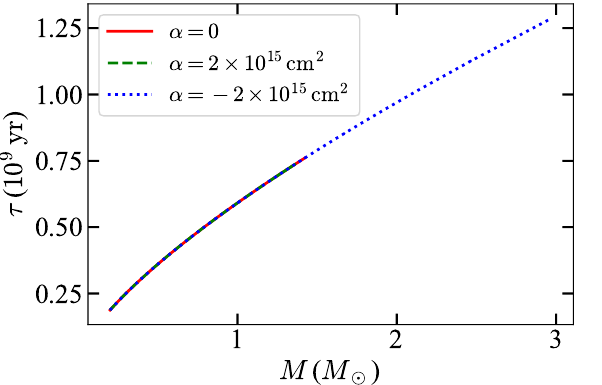
Figure 2. Cooling timescale as a function of the mass of the WDs for L ∗ = 10 − 3 L (cid:12) . Notice that modified gravity allows the white dwarf stars to have higher masses than the Chandrasekhar limit.